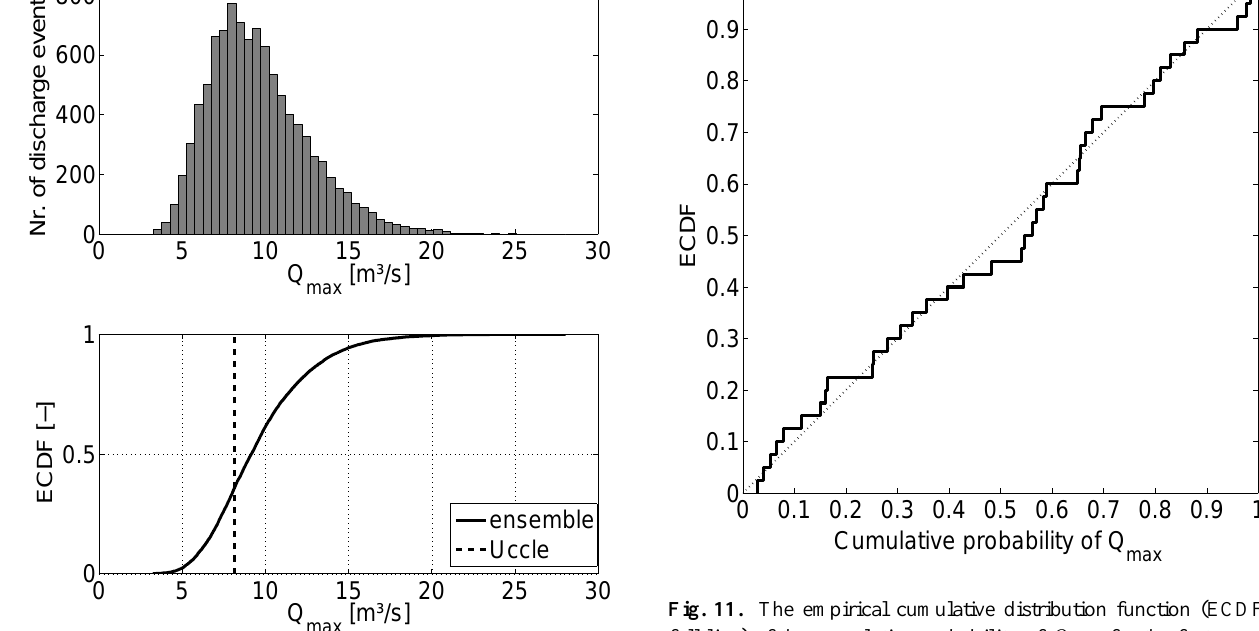
Fig. 11. The empirical cumulative distribution function (ECDF; full line) of the cumulative probability of Q max for the forty most extreme summer storm events corresponds with a uniform one (dotted